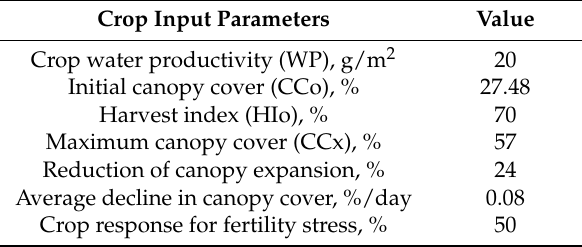
Table 2. The input parameters for spring barley that were adjusted for a specific cultivar.